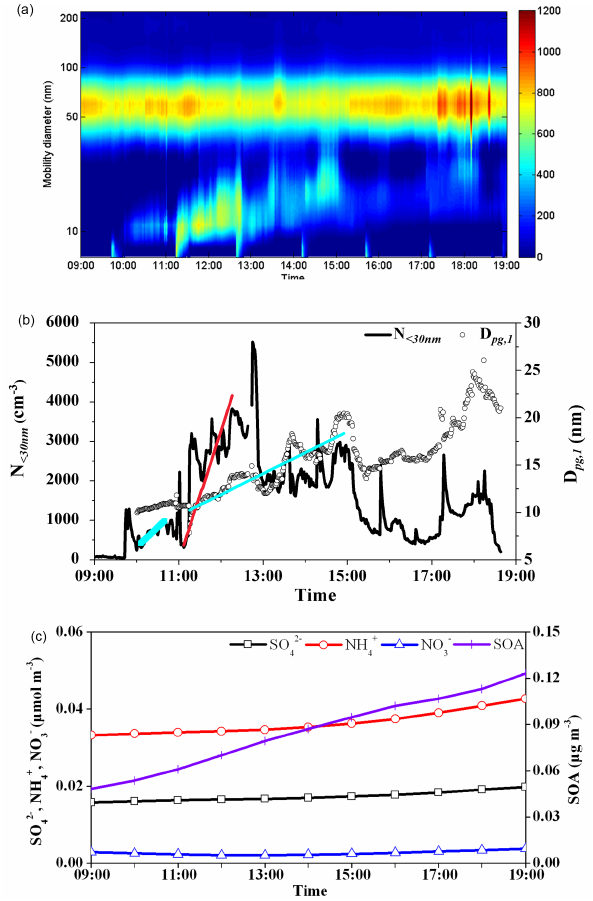
Figure 5. New particle formation on 19 October 2011 a particle number concentrations from FMPS (cm − 3 ), (b) variations of me- dian diameter of particle mode ( D pg , 1 ) and number concentrations of nucleation mode particles ( N < 30nm ), (c) CMAQ simulation of SO 2 − , NH + , NO − and SOA in PM 2 . 5 . 4 4 3